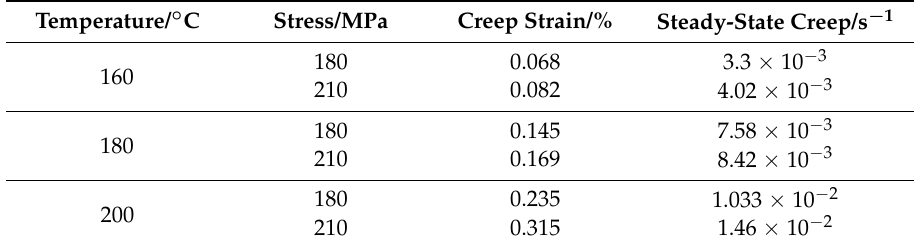
Figure 3. Creep curves of Al-Cu-Mg alloy under different aging temperature and stress levels: ( a ) 180 MPa; ( b ) 210 MPa. Table 2. Creep strain and steady-state creep rate of Al-Cu-Mg alloy under different aging temperature and stress levels.